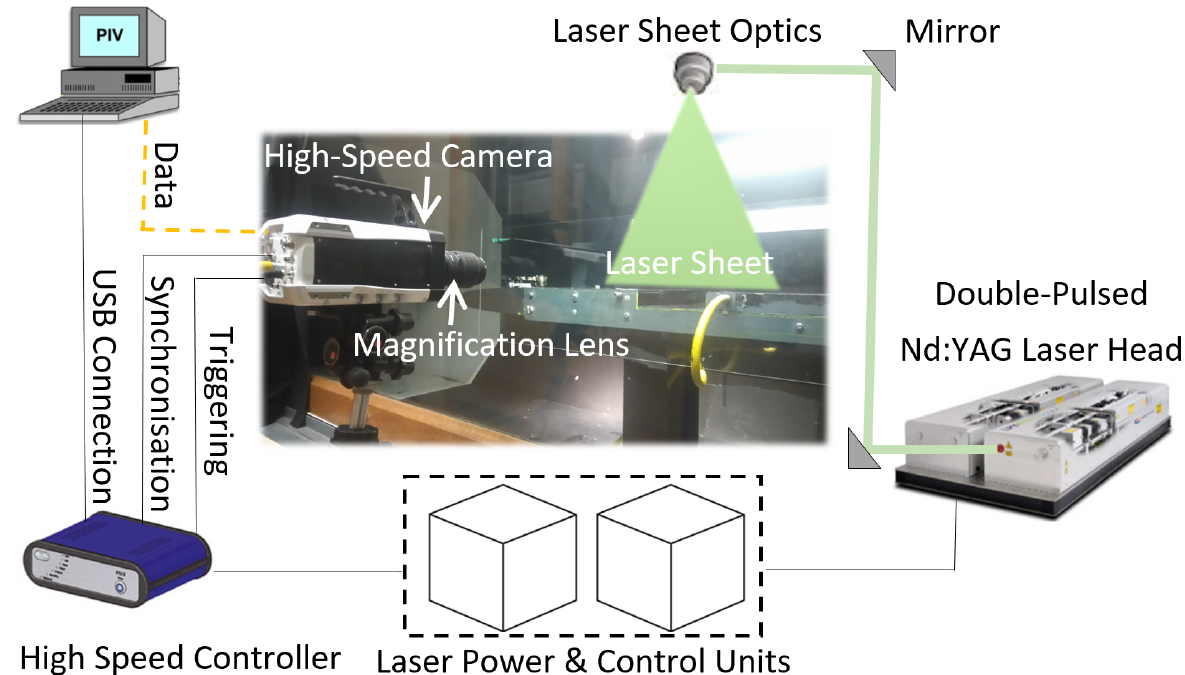
Figure 3. The experimental setup for the two-dimensional